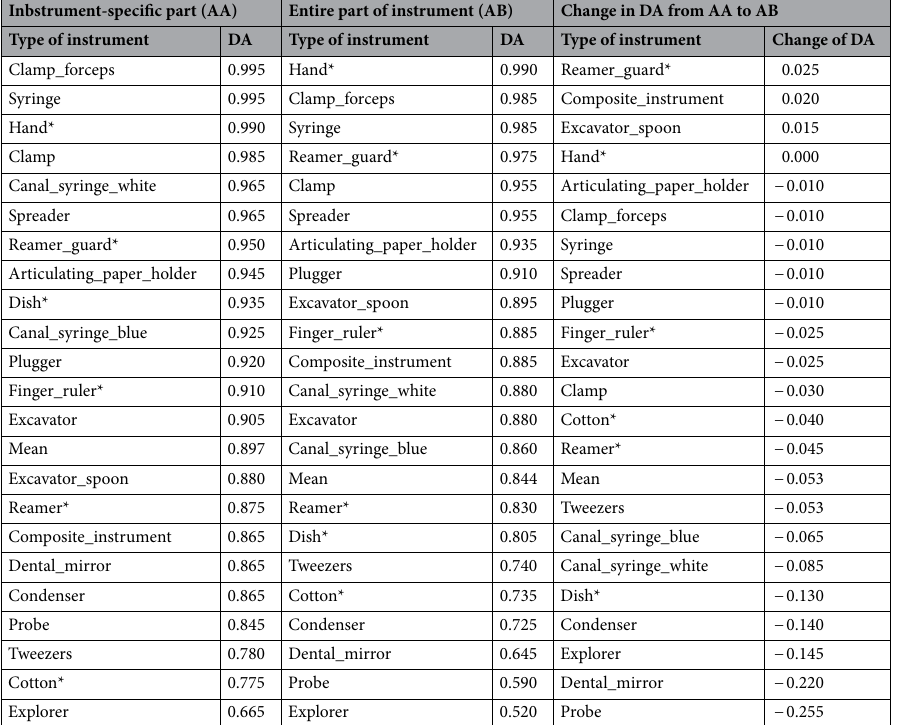
Table 5. DA of each instrument and changes according to annotation method (YOLOv7).